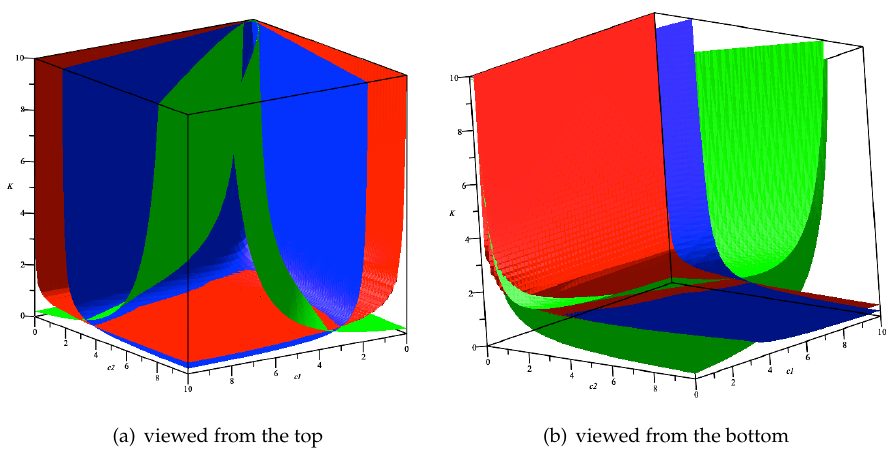
Figure 1. The 3-dimensional ( c 1 , c 2 , K ) parameter space. The red, blue and green surfaces are N = 0, L 1 = 0 and L 2 = 0,